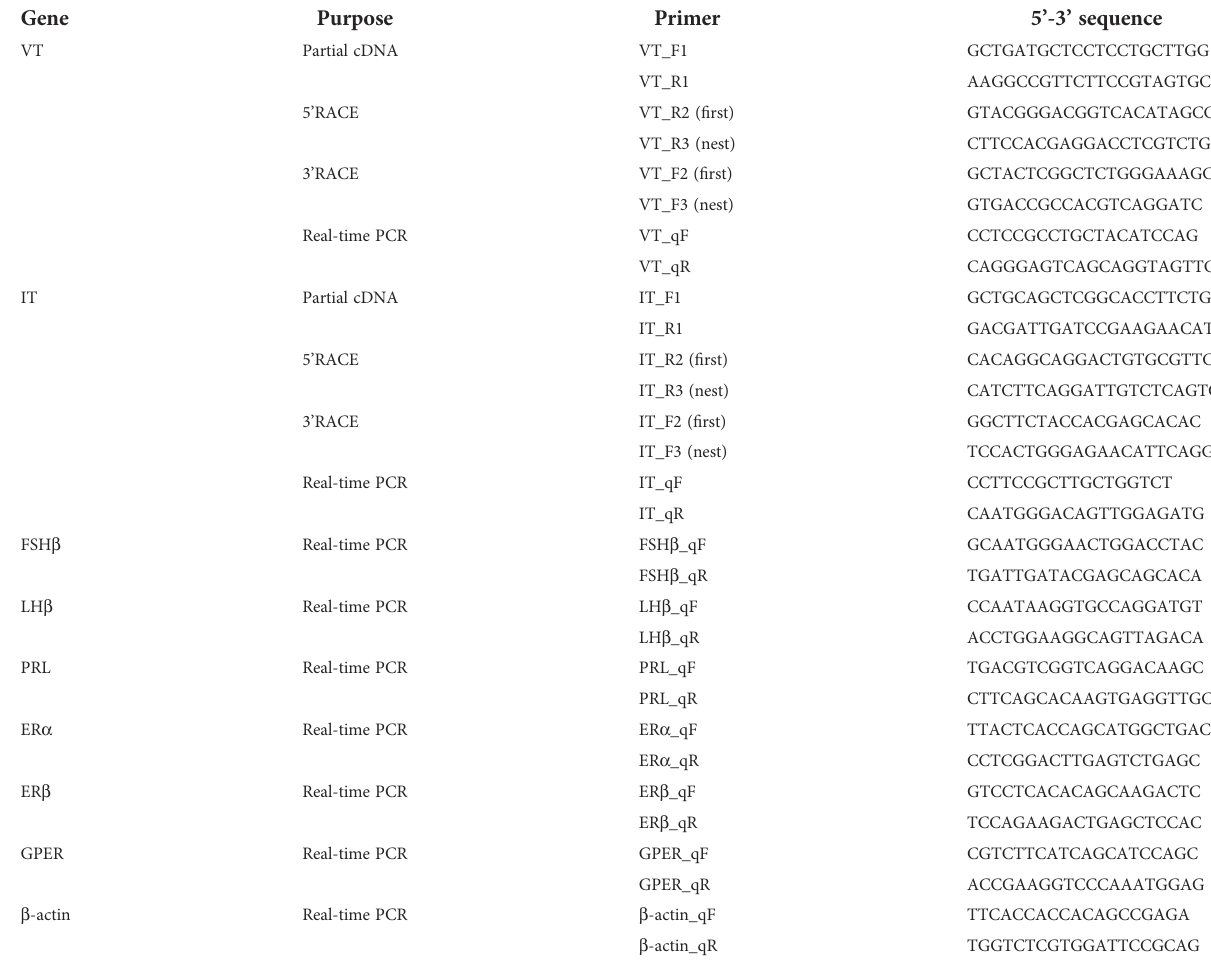
TABLE 1 Information of primers used in this